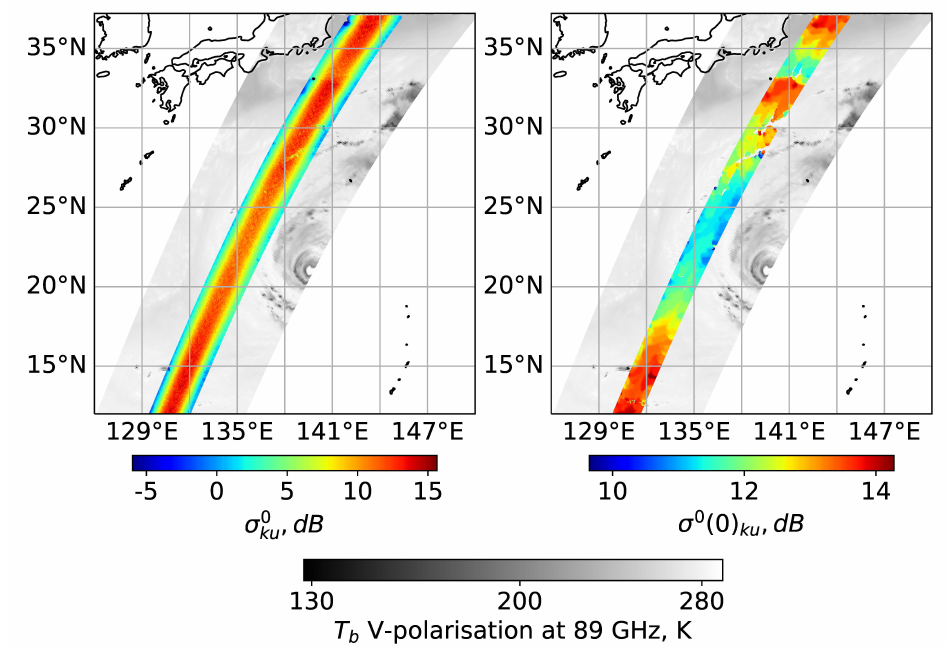
Figure 1. Raw data of Ku-band radar ( left ) and retrieved NRCS at nadir ( right ) over the image of brightness temperature from GMI data at 89 GHz, V-polarization. The track passes over the typhoon Hagibis at 09:40 GMT on 9 October